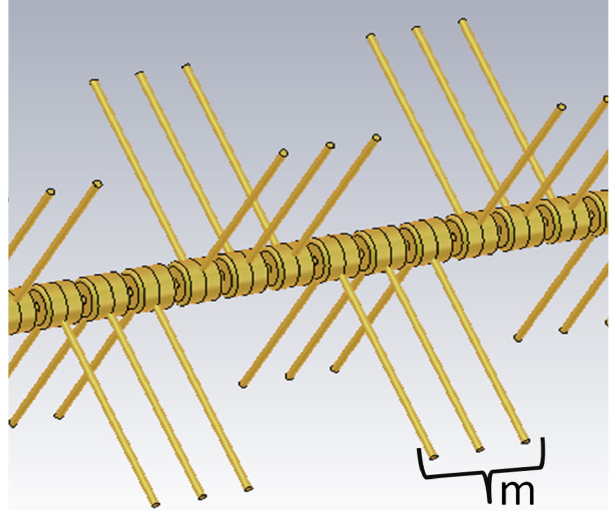
FIG. 14. Local minimization of transverse admittance by grouping of stems. The frequency of the TE 010 -mode depends on the stem number m per group. For field stabilization m must be determined such that its frequency gets close to the operating frequency ω 0 of 108.4 MHz.